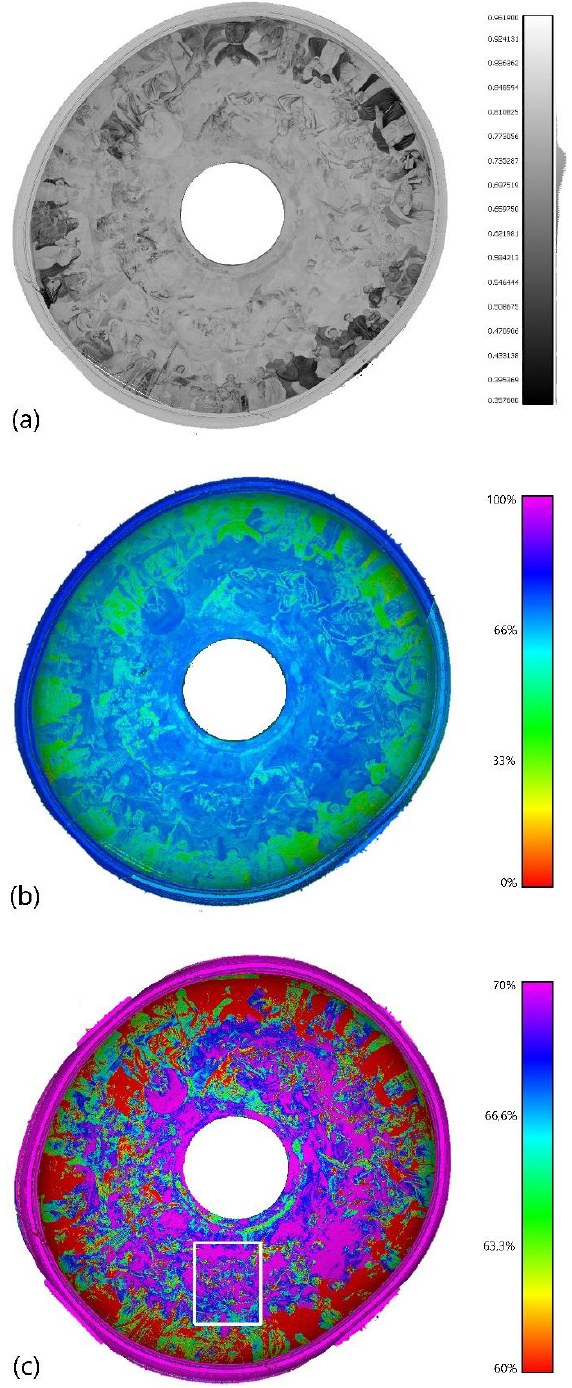
Figure 5 . Manipulation of the reflectance maps obtained with the TLS survey (a, b). By varying the range of the percentage value (c) it is possible to extract progressively more significant information for the damaged portions of the fresco.